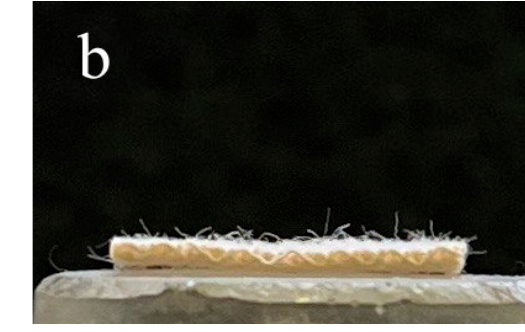
Figure 3. Photos of a sessile drop of ( a ) water and ( b ) the complete spreading of ethanol on the surface of phosphorylated cotton fabric.